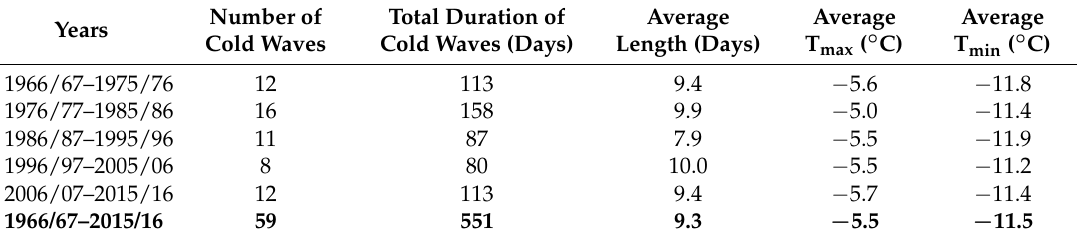
Table 2. Characteristics of cold waves in the period 1966/67–2015/16 in